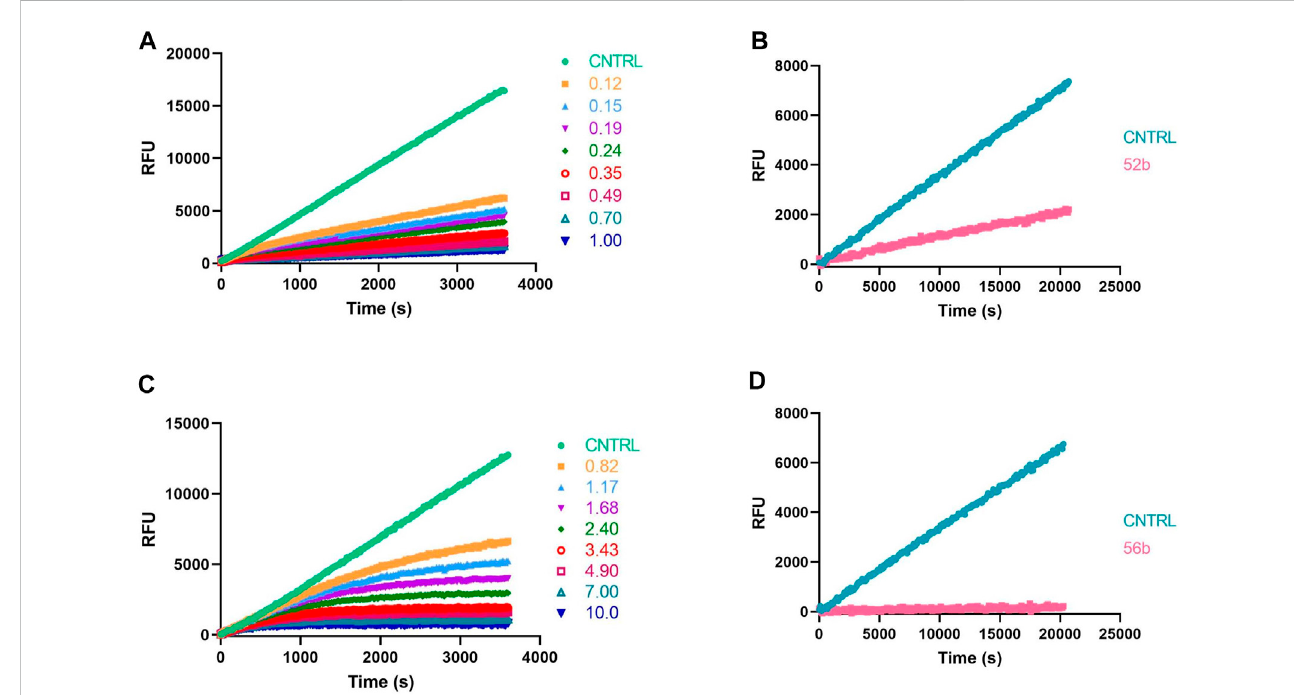
Kinetic progress curves; legend concentrations in µM (A,C) and jump dilutions (B,D) of β -tryptase; (A,B) Reversible compound 52b; (C,D) Irreversible compound